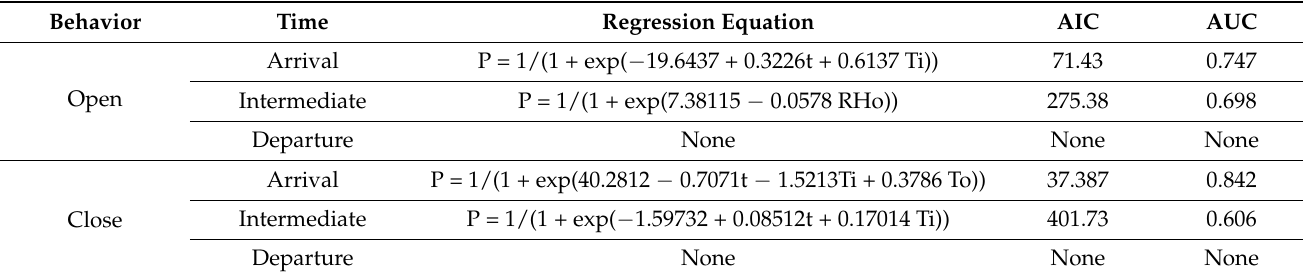
Table 4. Regression model for window use behaviors.